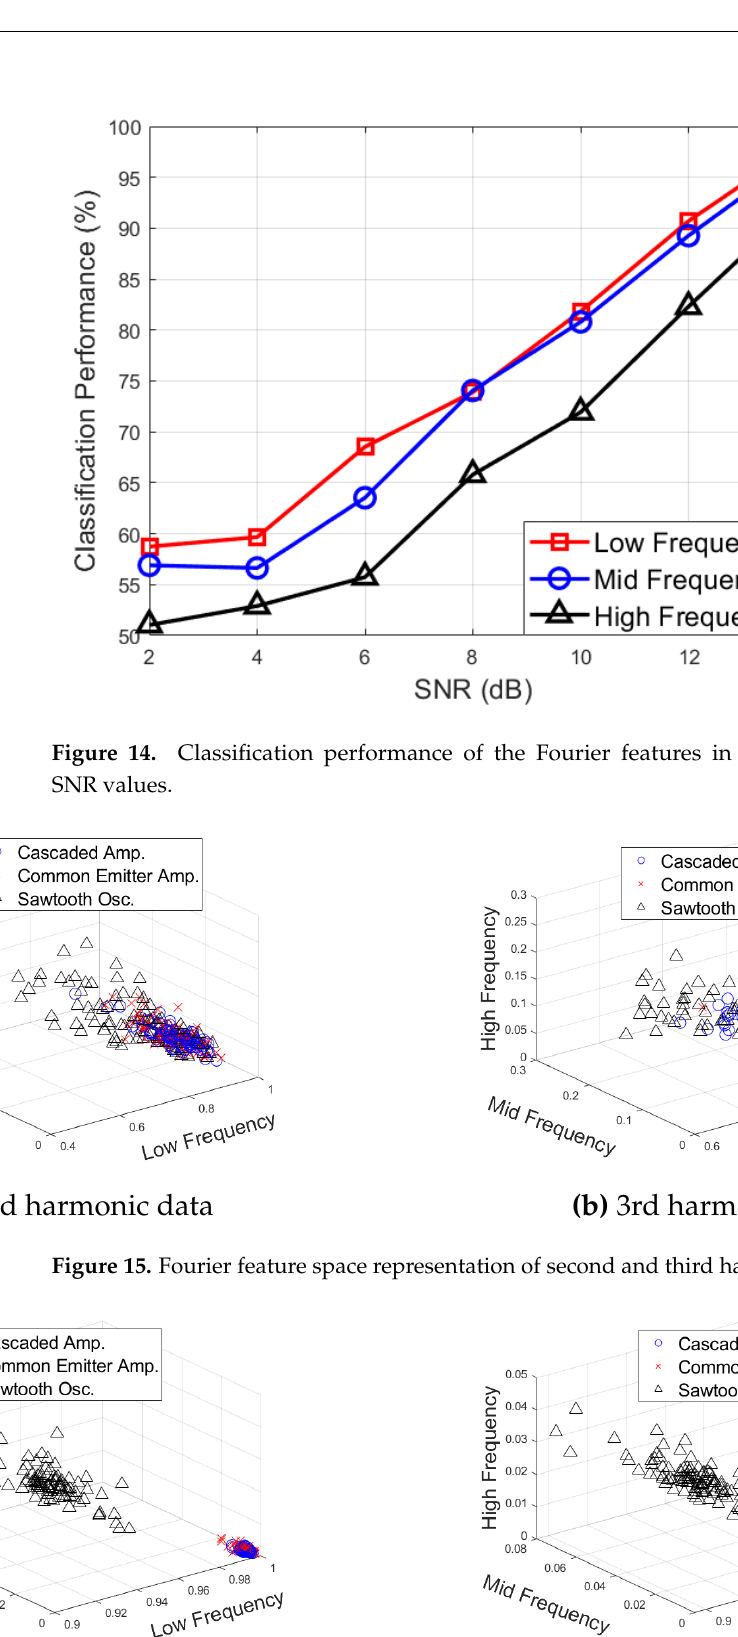
(c) High frequency data Figure 13. Scattered plots of Fourier features in 3D harmonic space, SNR=14 dB. indicate similar classification performance. However, one can observe that low and mid frequency 313 Table 4. Confusion matrices for Fourier features in first, second and third harmonic space for SNR=8 dB.